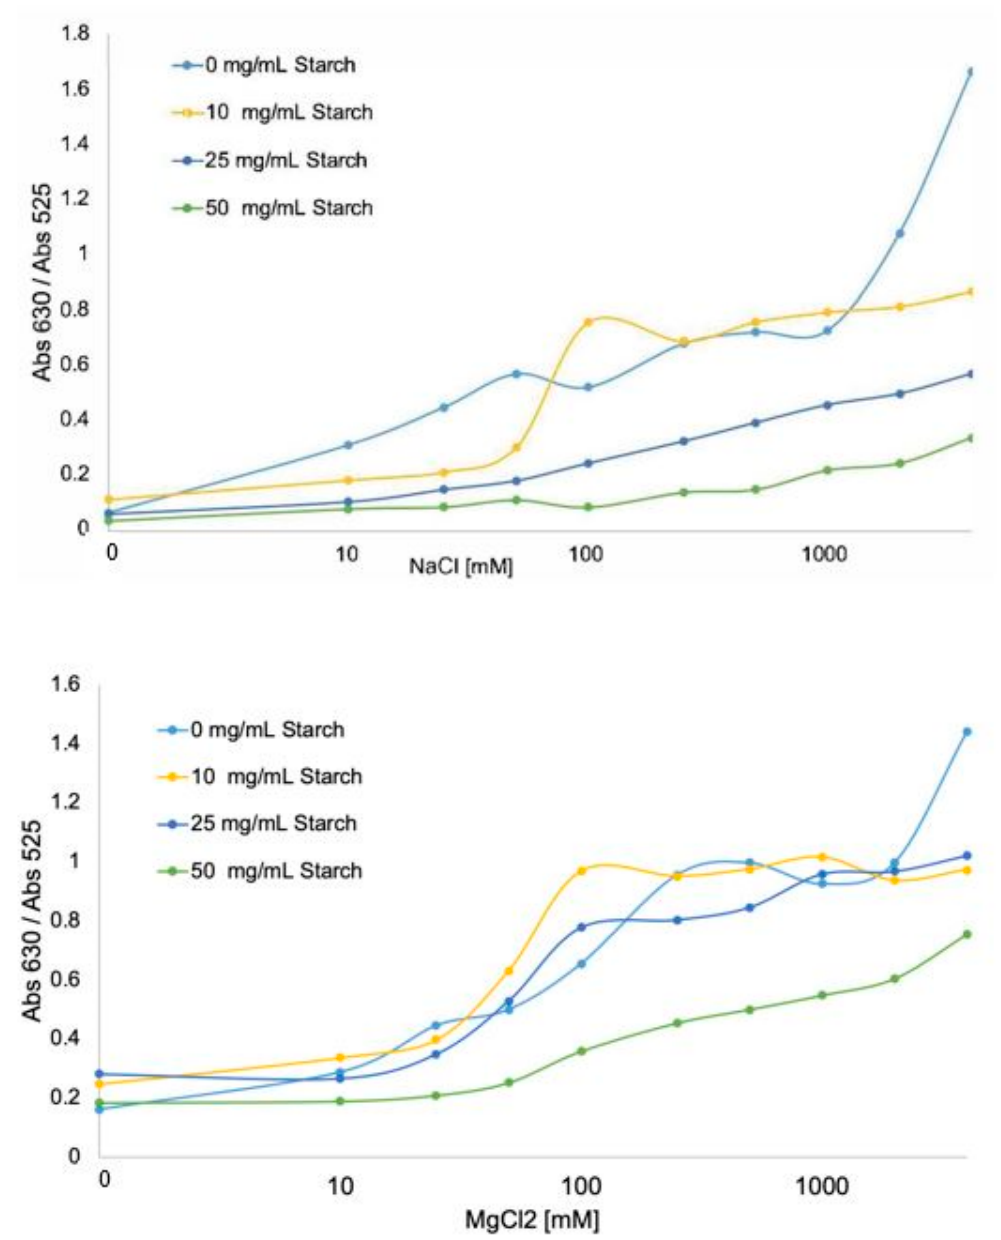
Figure 3. Plots of the concentration of salt versus absorbance ratio (Abs 630 / Abs 525 ). The e ff ect of di ff erent concentrations of salt on the aggregation level of AuNPs at di ff erent concentration of Starch solution is shown. ( A ) NaCl; ( B ) MgCl 2 3.3. Determination of the Stabilization Mechanism